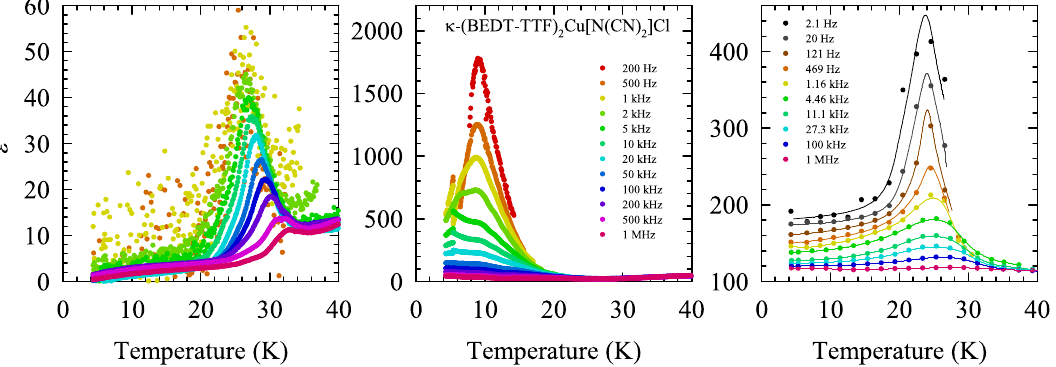
Figure 4. Real part of the dielectric function ε (cid:48) as a function of temperature with the ac electric field applied E (cid:107) b for three representative single crystals of κ -Cl: S1 ( Left ); S2 ( Middle ); and S3, after [18] ( Right panel ) The full lines in ( Right ) are guides for the